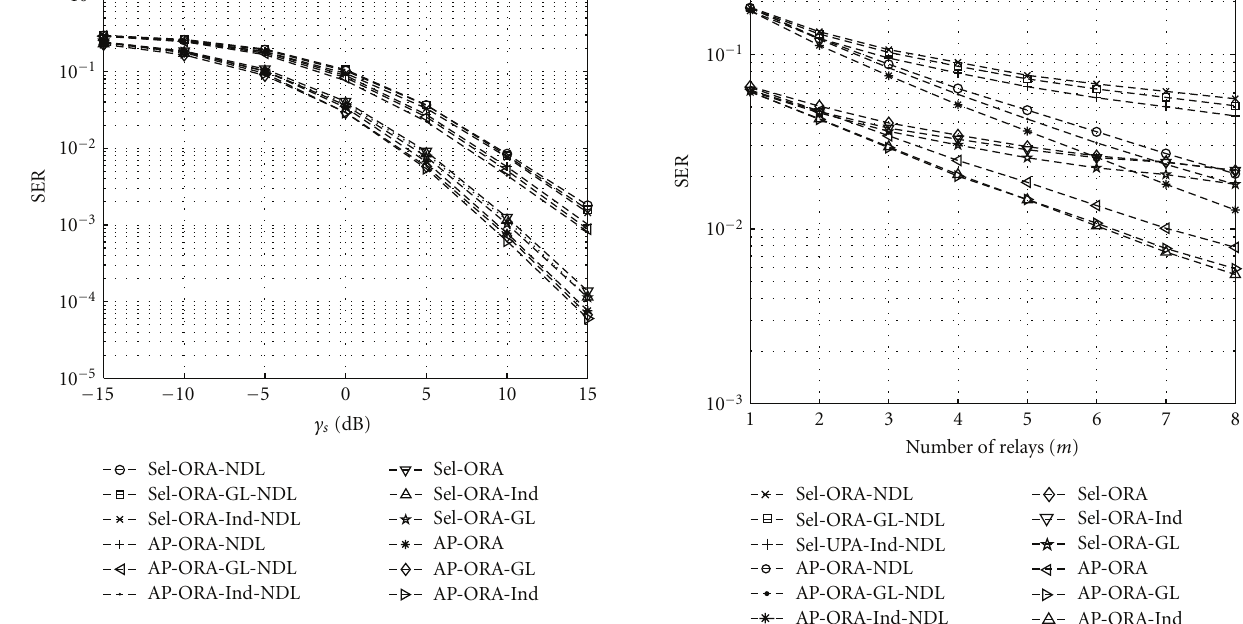
Figure 8: Comparison of AP vs Sel with m = 3. Figure 9: Comparison of AP versus Sel as a function of m